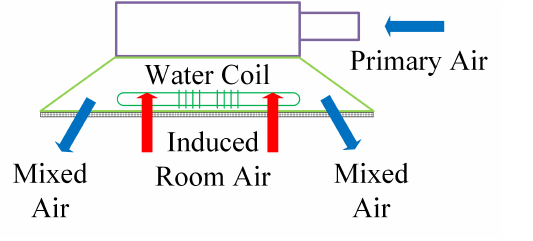
Figure 5. Schematic representation of